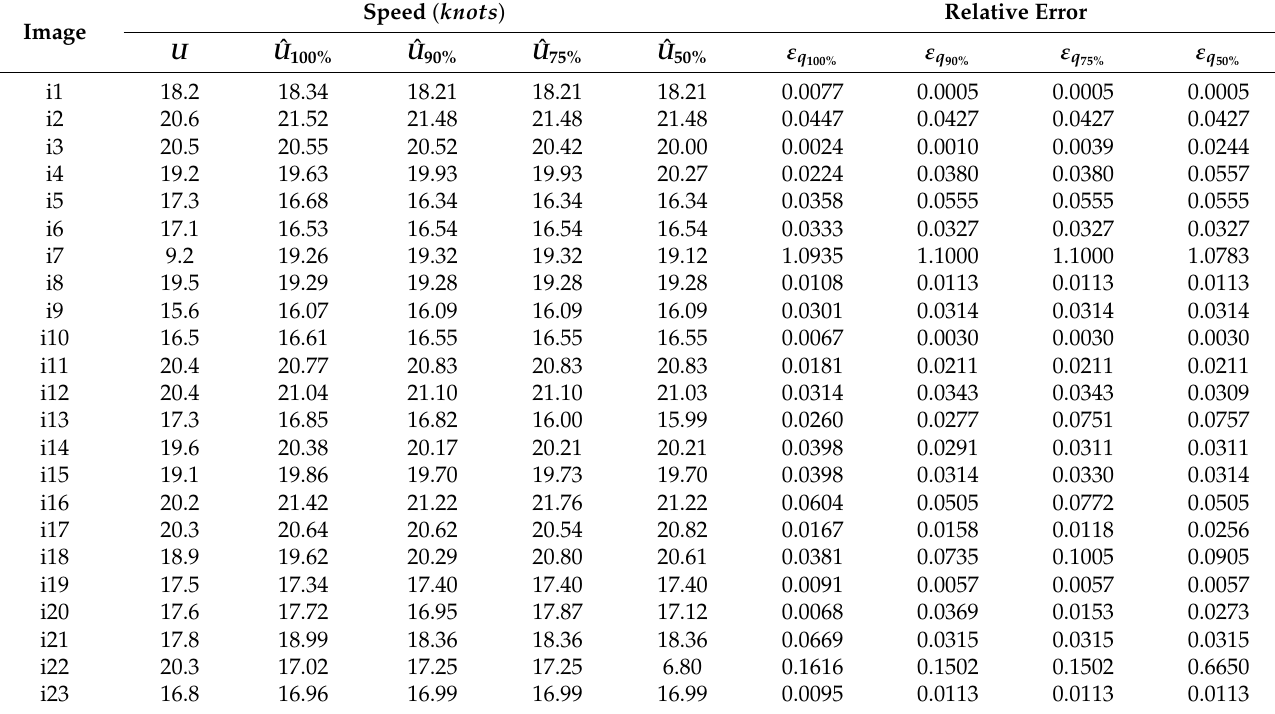
Table 4. Variation in estimated speeds as a function of image compression: U is the speed that was measured by the radar; ˆ U q and ε r are the speed that was estimated by our approach and the relative q error of using an image at quality compression q , respectively; and q = 100% for the original